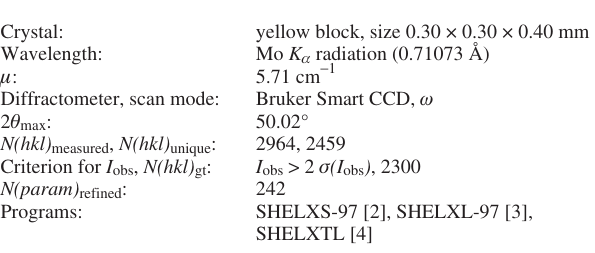
Table 1. Data collection and handling.